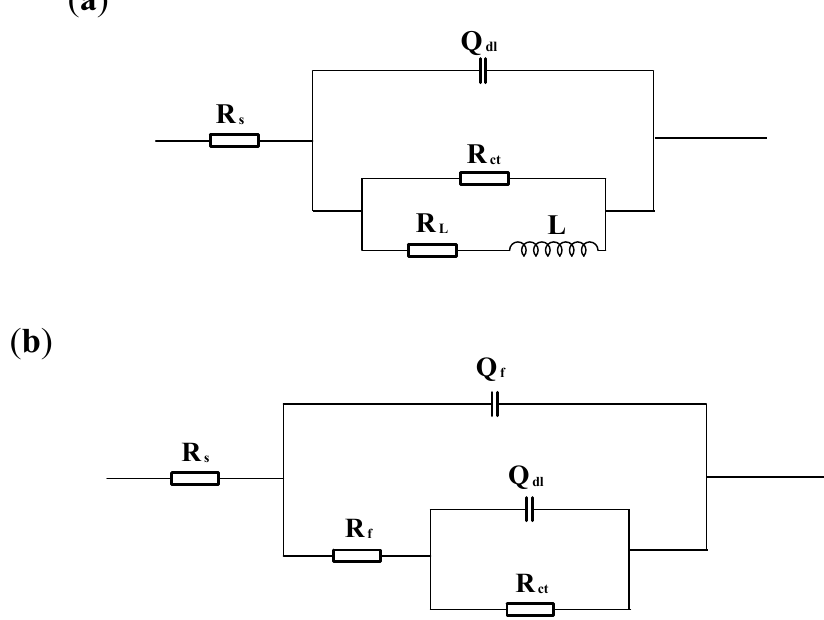
Figure 6. Electrochemical equivalent circuits: ( a ) under flow conditions; ( b ) under static-state Figure6. Electrochemicalequivalentcircuits: ( a )underflowconditions; ( b conditions. Table 1. Electrochemical parameters fitted from the electrochemical impedance spectroscopy (EIS) data of typical array electrodes 6 (outside) and 14 (inside).